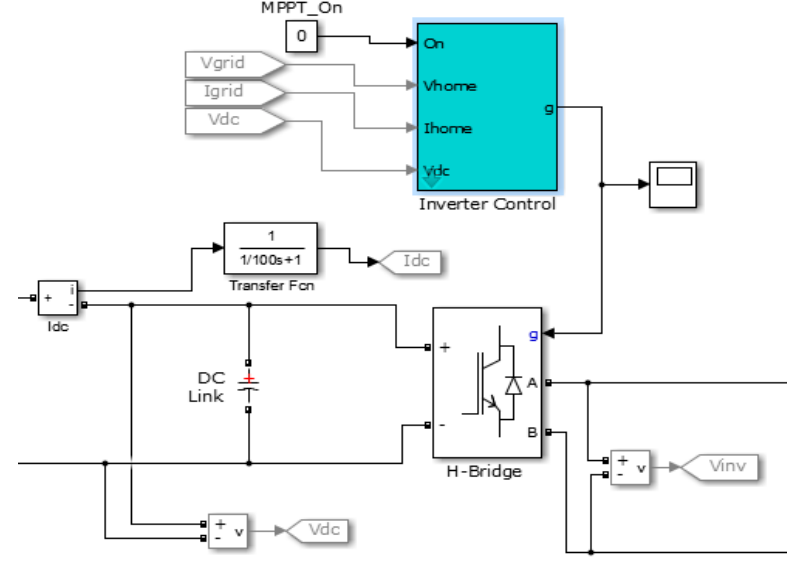
Figure 5. Model of the four-quadrant (4Q) converter and its control system.